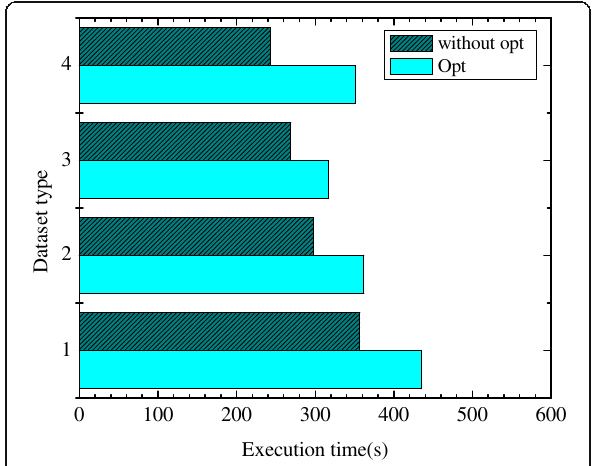
Fig. 2 Comparison of execution time for different strategies